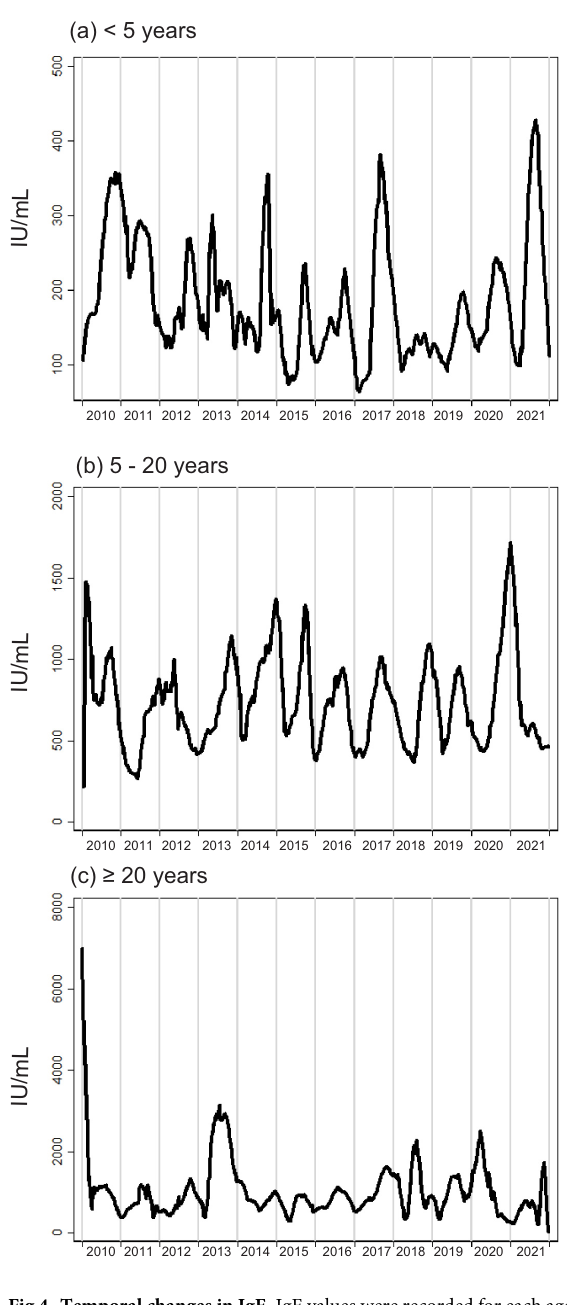
Fig 4. Temporal changes in IgE. IgE values were recorded for each age group, (a) < 5 years, (b) 5–20 years, and (c) � 20 years, and were smoothed using the Lowess method (bandwidth = 14 days).